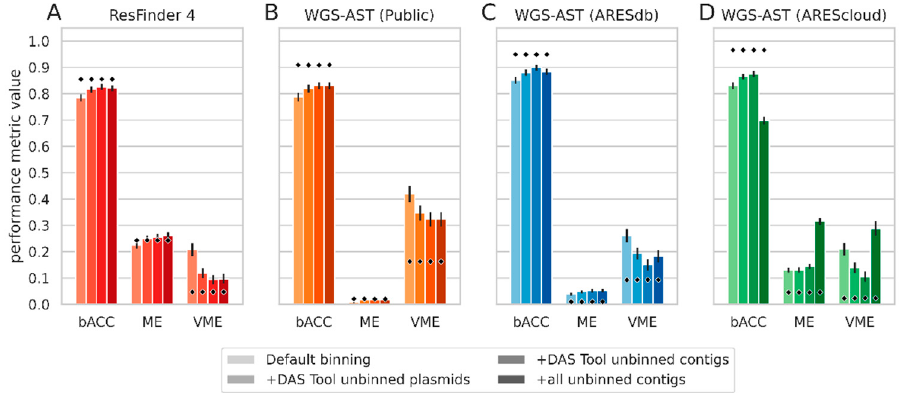
Figure 3. Performance metrics of genomic AST methods on metagenomic bins derived from simulated E. coli/K. pneumoniae co-infection cUTI metagenomes using different binning and AST prediction settings. Height of the bars indicates values taken on by bACC, ME, and VME in each investigated experimental setting. Metrics are averaged over 5 antibiotic compounds. Legend elements correspond with bars in each subfigure by color saturation, from lightest to darkest color. Diamonds indicate the mean value taken on by metrics of the tested method on isolate genome assemblies used to construct the metagenomes. ( A ), ResFinder 4 performance; ( B ), Performance of WGS-AST models from [5] trained on public data; ( C ), Performance of WGS-AST models trained analogously to [5] but including proprietary data from ARESdb [13]; ( D ), Performance of default AREScloud [17,18] WGS-AST models (optimized for application to isolate genome assemblies) trained on data as in C but using an extended feature space. bACC, balanced accuracy. ME, major error. VME, very major error. Error bars are 95% confidence interval obtained by 1000× bootstrapping.